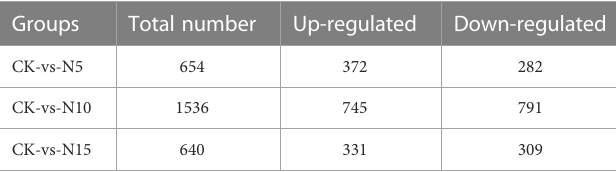
TABLE 1 The number of DEGs in three comparison groups.